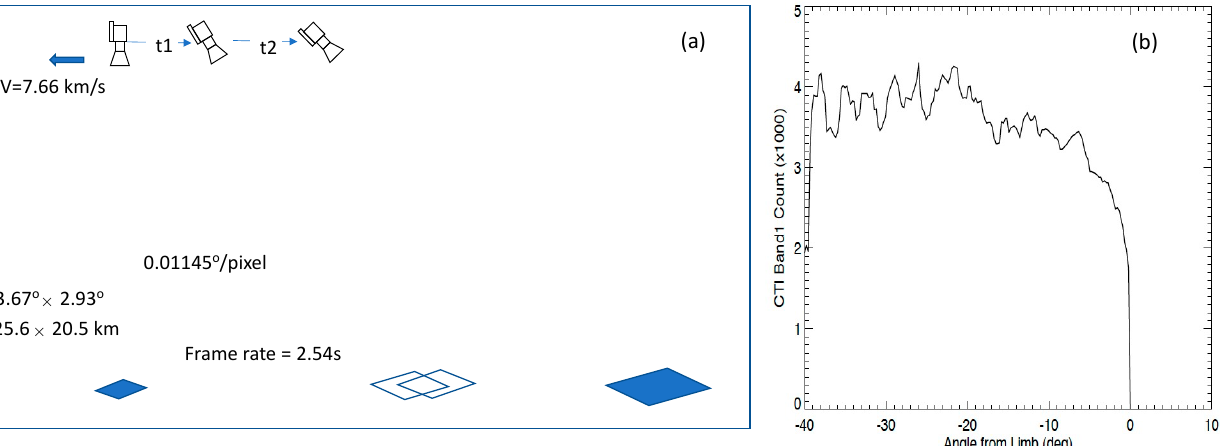
Figure 1. ( a ) Schematic of ISS pitch-up operation showing CTI view-angle changes from a slant view to limb views; ( b ) limb darkening effect seen in the CTI count measurements from 1 August 2019. The band1 data were frame-averaged count measurements from the warmest 100 pixels in each frame. The count fluctuations between − 40 ° and − 10 ° from the limb capture the influence of clouds during the pitch-up operation.